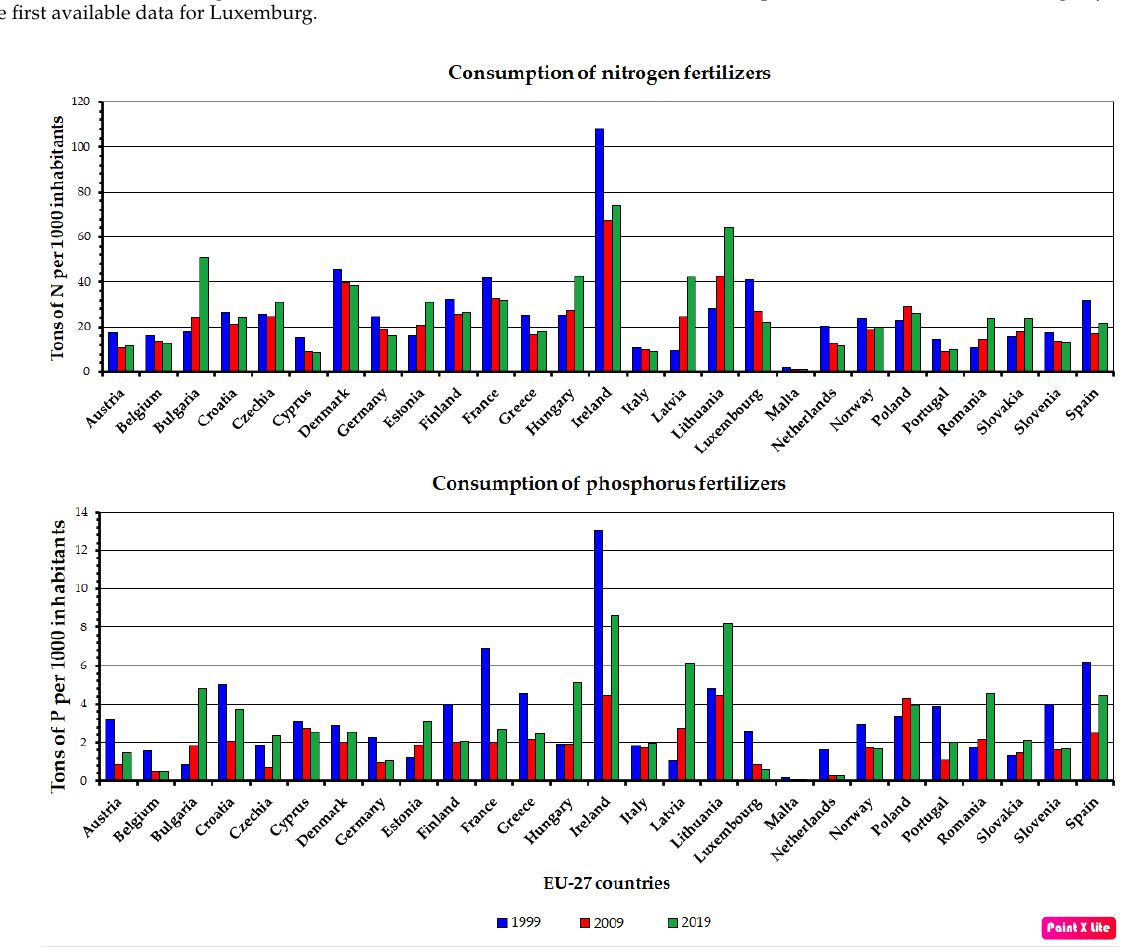
z Fertilizers considered in this table are all products based on nitrogen, potassium, and phosphorus (NPK) elements. This data does not include either animal or vegetative manure (data source: The World Bank—World Development Indicators, [34]). y Referring to year 2002, the first available data for Luxemburg.